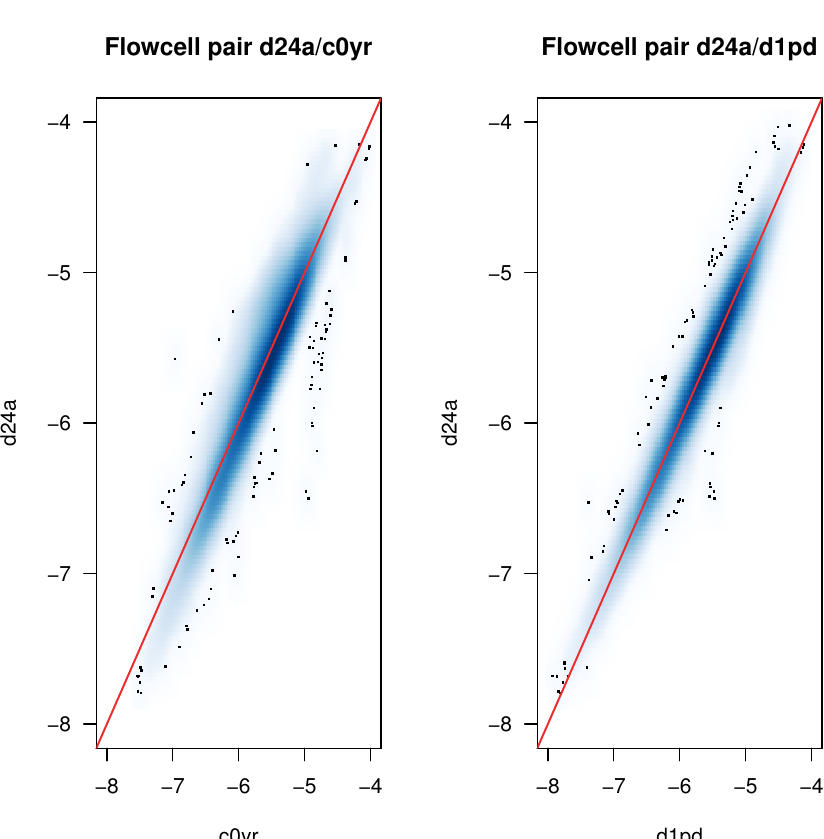
Figure 9. K-mer spectrum responsible for tree separation: Comparison of K-mer counts in two Flowcell pairs using density scatter plots: All axes represent normalised and log k-mer counts on a whole Flowcell (each 8 Fastq files). The diagonal (red line) indicates equal normalised counted numbers for k-mers in both Flowcells. The luminosity of the blue area indicates point-density in the scatter plot (dark = high density). Left panel : Comparison of k-mer counts on Flowcells d24a / c0yr (strong batch effect (=b1a) identified by HcKmer). Right panel : Comparison of k-mer counts on Flowcells d24a / d1pd (no batch effect (=es) identified by HcKmer). Result: The k-mer count differences are larger for d24a / c0yr (mean = 0.30, sd = 0.12) than for d24a / d1pd (mean = 0.01, sd = 0.07). The HcKmer diagnosed difference of sample similarity between the Flowcell pairs is due